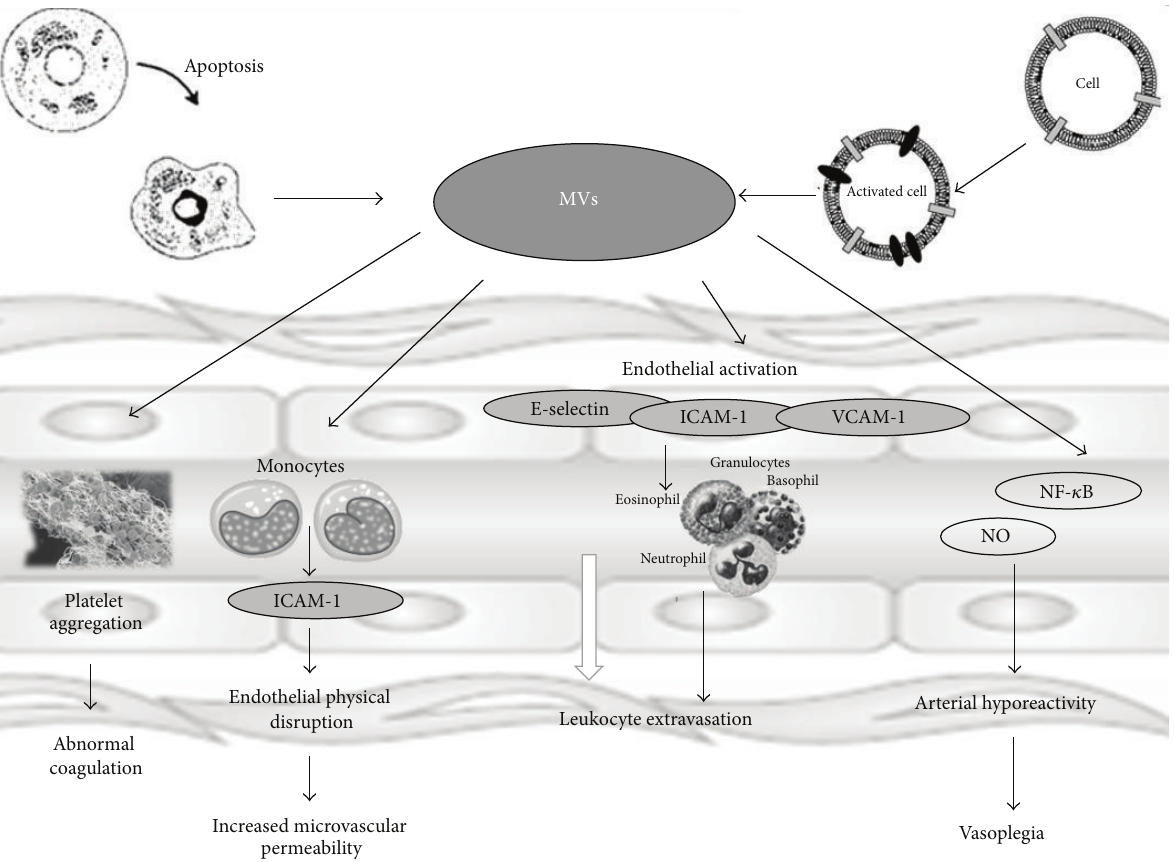
Figure 3: A schematic representing microvesicles (MVs) functions. MVs are released in the extracellular environment through a membrane reorganization and blebbing process following cell activation or apoptosis. They contribute to the spread of inflammatory and prothrombotic vascular status and they may affect smooth muscle tissue through adhesion molecules (E-selectin, ICAM, and VCAM) activation of nuclear factor 𝜅 B and the expression of inducible nitric oxide synthase and cyclooxygenase-2, with an increase in nitric oxide (NO) and vasodilator prostanoids, leading to arterial